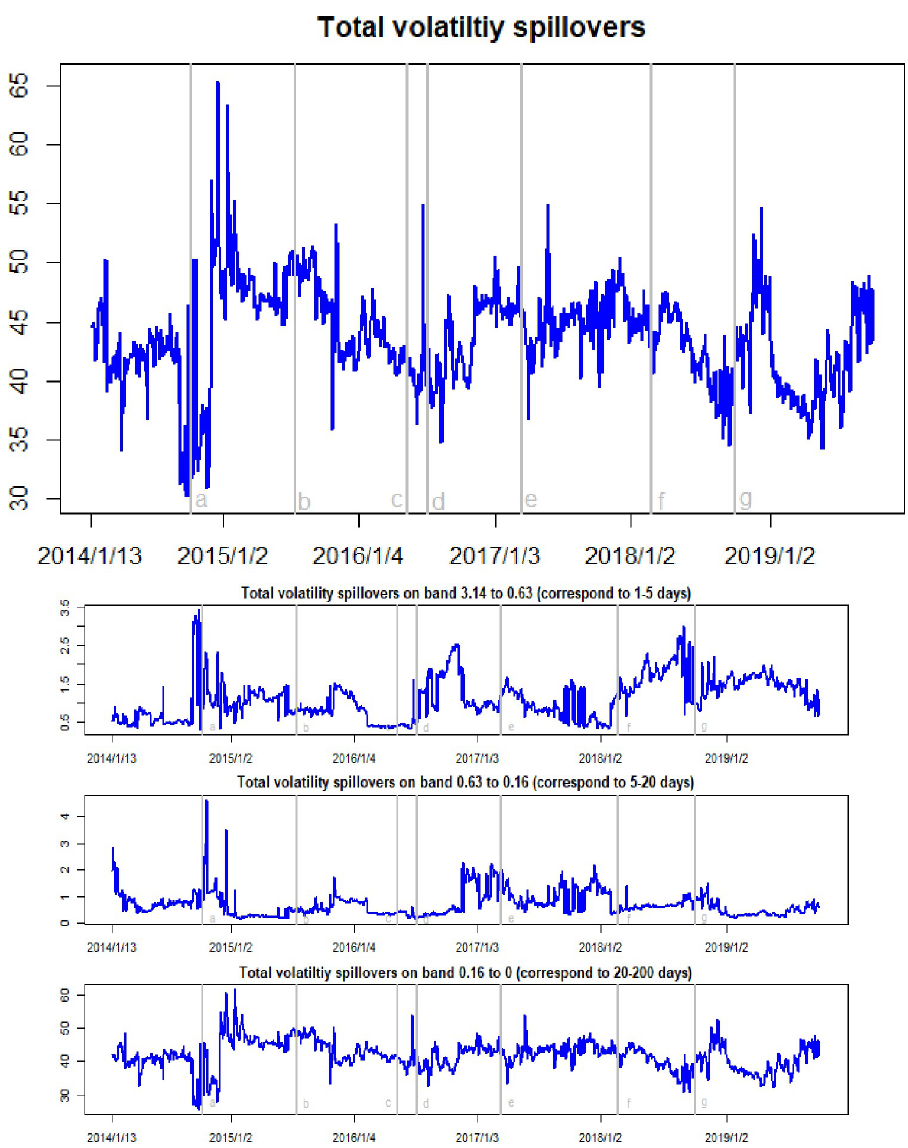
Fig 6. Time-frequency dynamics of total volatility spillovers. a, b, c, d, e, f, g respectively represent the seven events: the WTI oil price collapsed in October 2014, the black swan event in gold market occurred in July 2015, the sharp rise of bitcoin prices in May 2016, the Brexit event in July 2016, the expectations of a Federal Reserve rate hike in March 2017, the price of Bitcoin and gold fluctuating fall at the beginning of 2018, and the WTI oil price declines in August 2018.